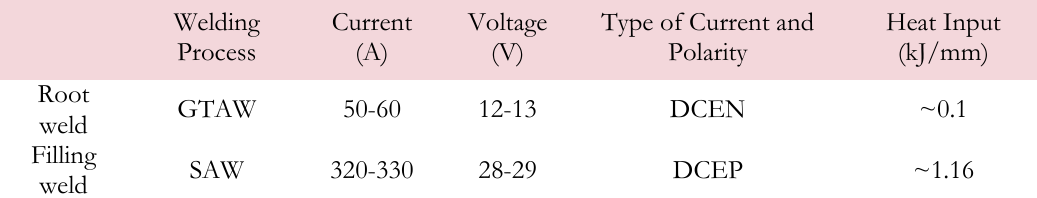
Table 4: Welding parameters.